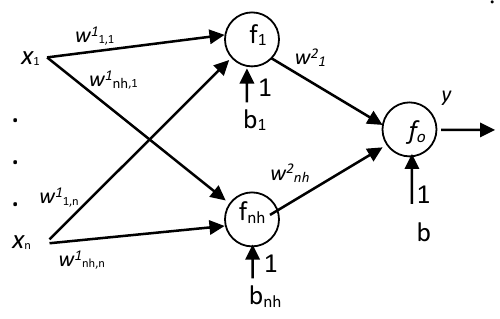
Figure 2. The feed forward neural